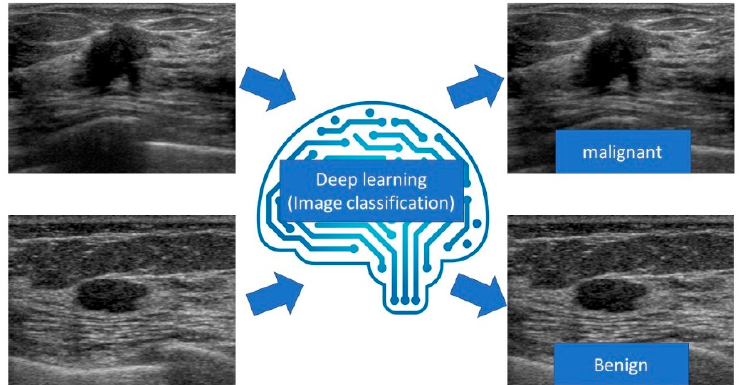
Figure 4. Diagram of image classification for breast ultrasound.